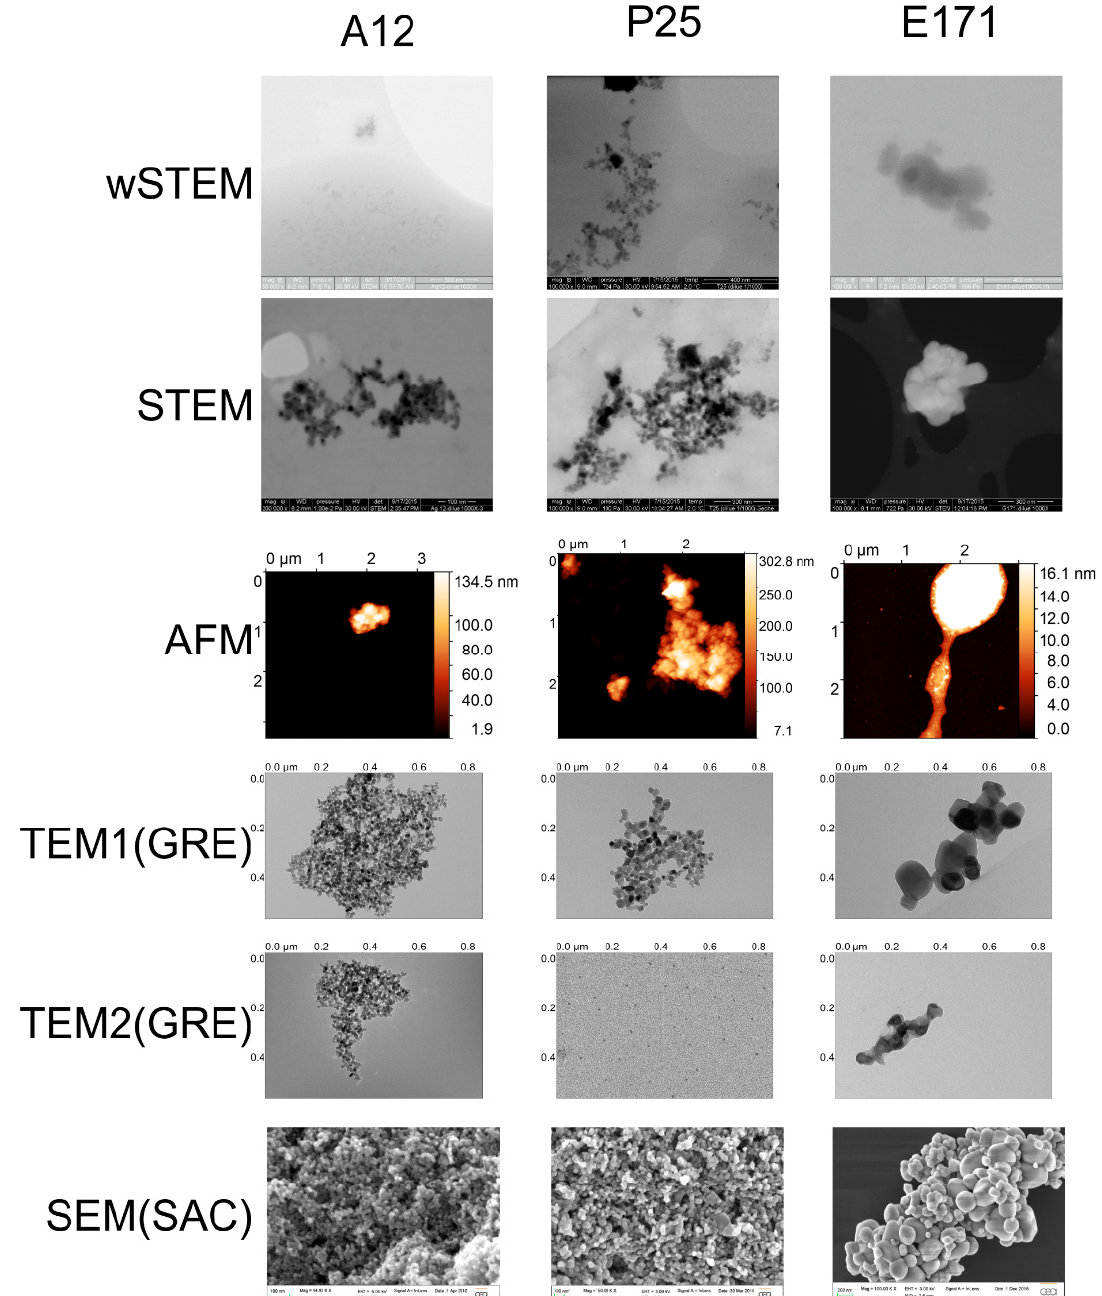
Figure 7. Samples of recorded microscopy images on TiO 2 NPs. Images show that, all three NPs, A12, P25, and E171, appear agglomerated in all techniques. Scale bars are indicated on the wSTEM, STEM or SEM images, whereas they appear on top of AFM or TEM images. The AFM image for E171 has been saturated to better visualize smaller NPs present in this sample. The difference between TEM1 and TEM2 images is in the method used for depositing samples: carbon floatation technique for the former or directly onto a carbon-coated grid for the latter (see methods).